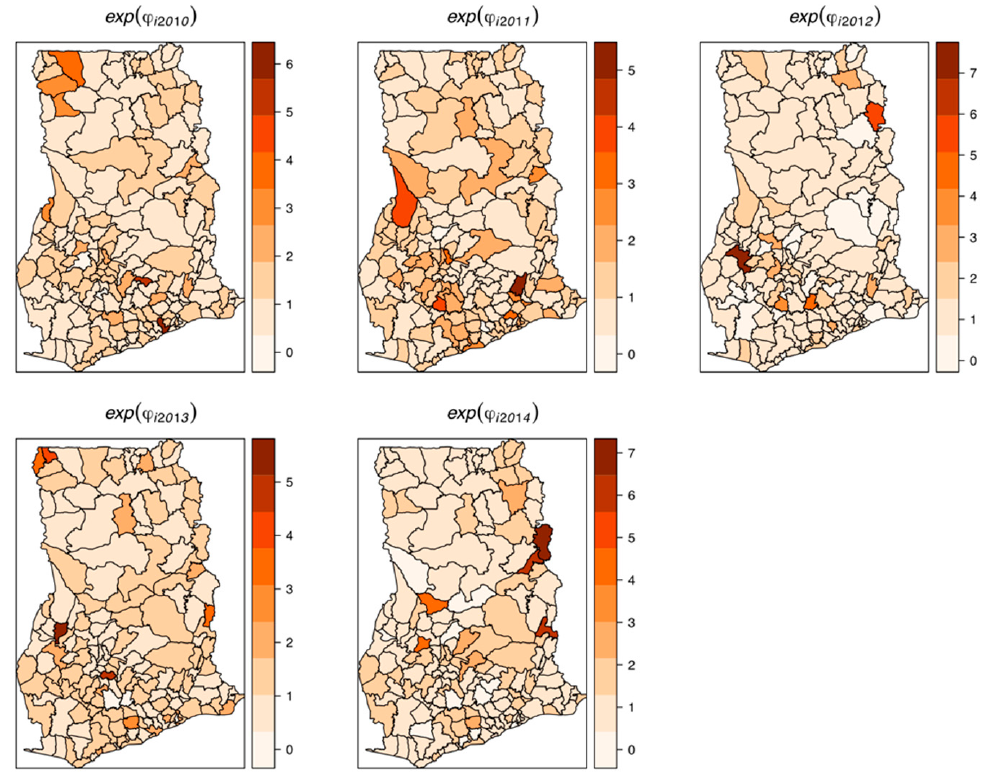
Figure 7. Maps of random space-time interaction effects, 2011–2014. These are also residual space-time variations after accounting for relevant covariates, temporal effects, and spatial effects.